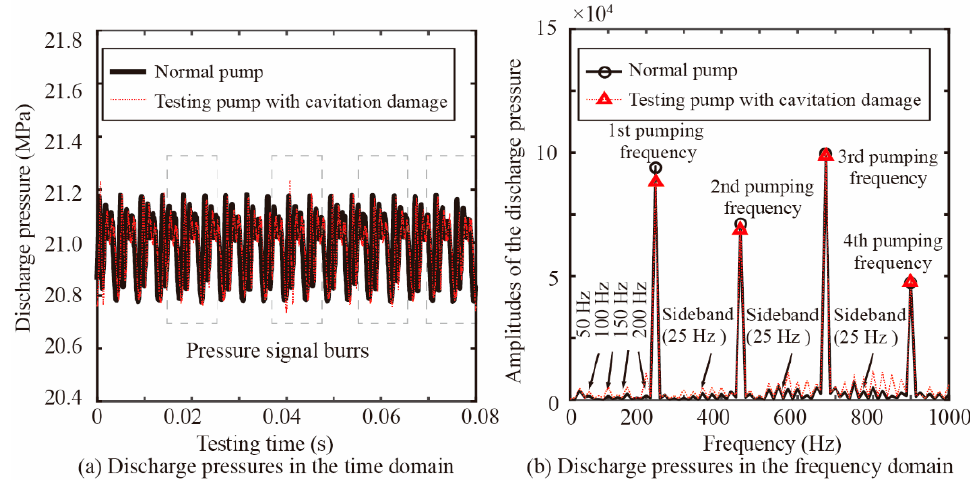
Figure 11. Comparisons of the tested discharge pressures and their spectra.